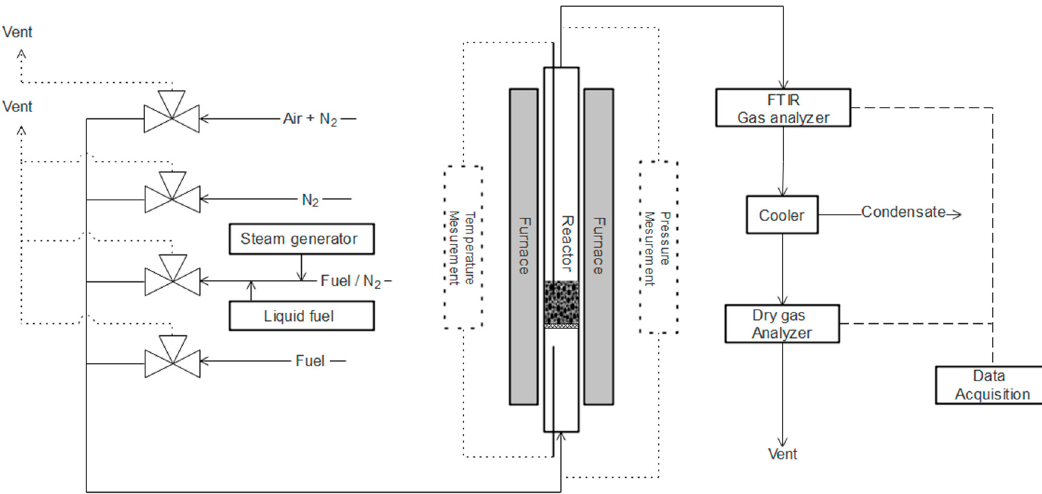
Figure 1. A schematic overview of the laboratory fluidized bed system.